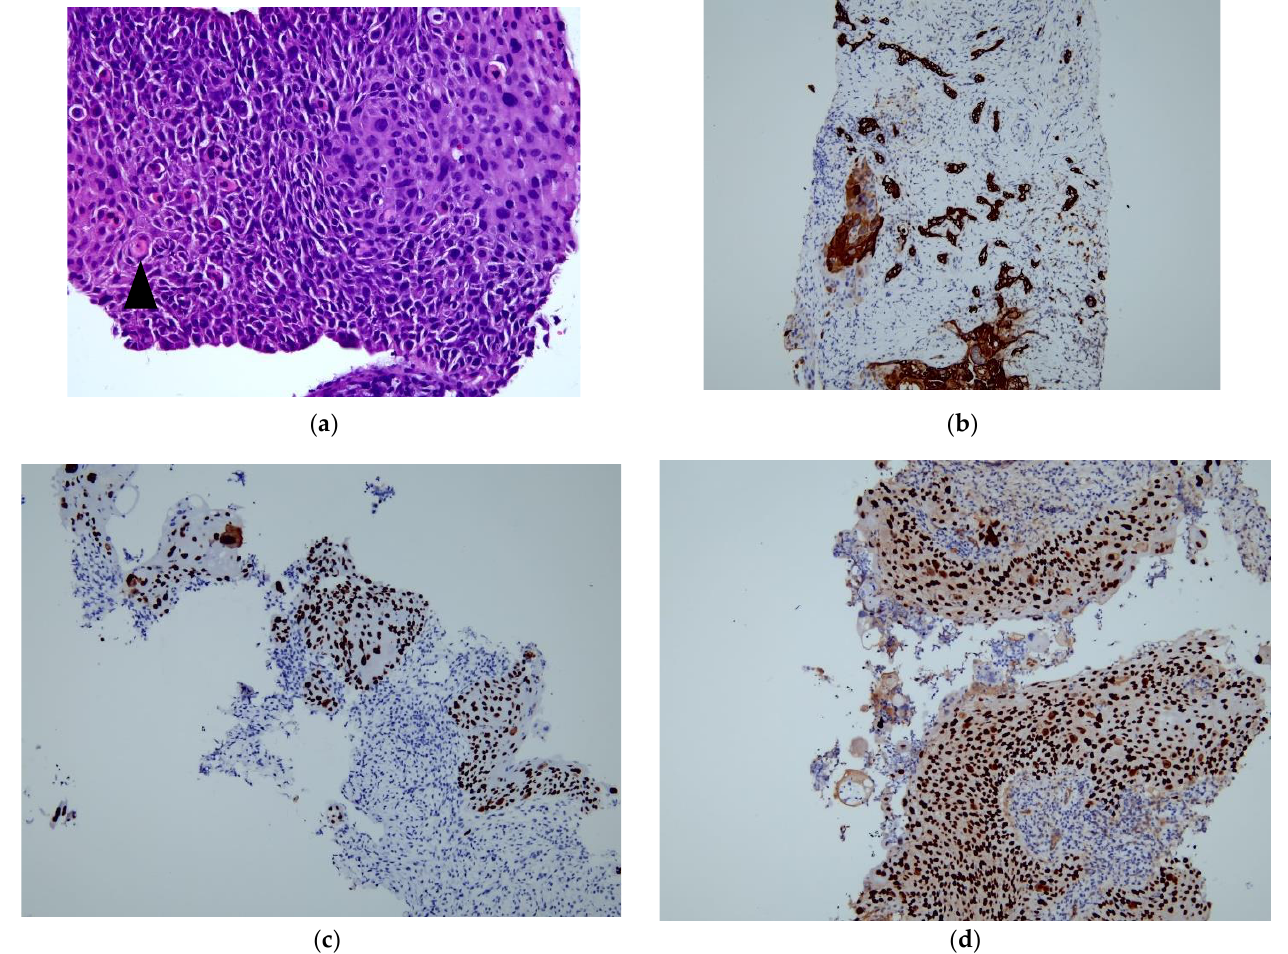
Figure 3. Microscopic evaluation of the lesion. ( a ) Squamous cell carcinoma (SCC) and keratin pearls (arrowhead) observed using hematoxylin and eosin staining (magnification, 200×). ( b ) Immunohistochemistry (IHC) results for cytokeratin 7 showing positivity for tumor cells (magnification, 100×). ( c ) IHC staining for p40 showing positivity for SCC (magnification, 100×). ( d ) IHC staining for p63 showing positivity for SCC (magnification, 100×).